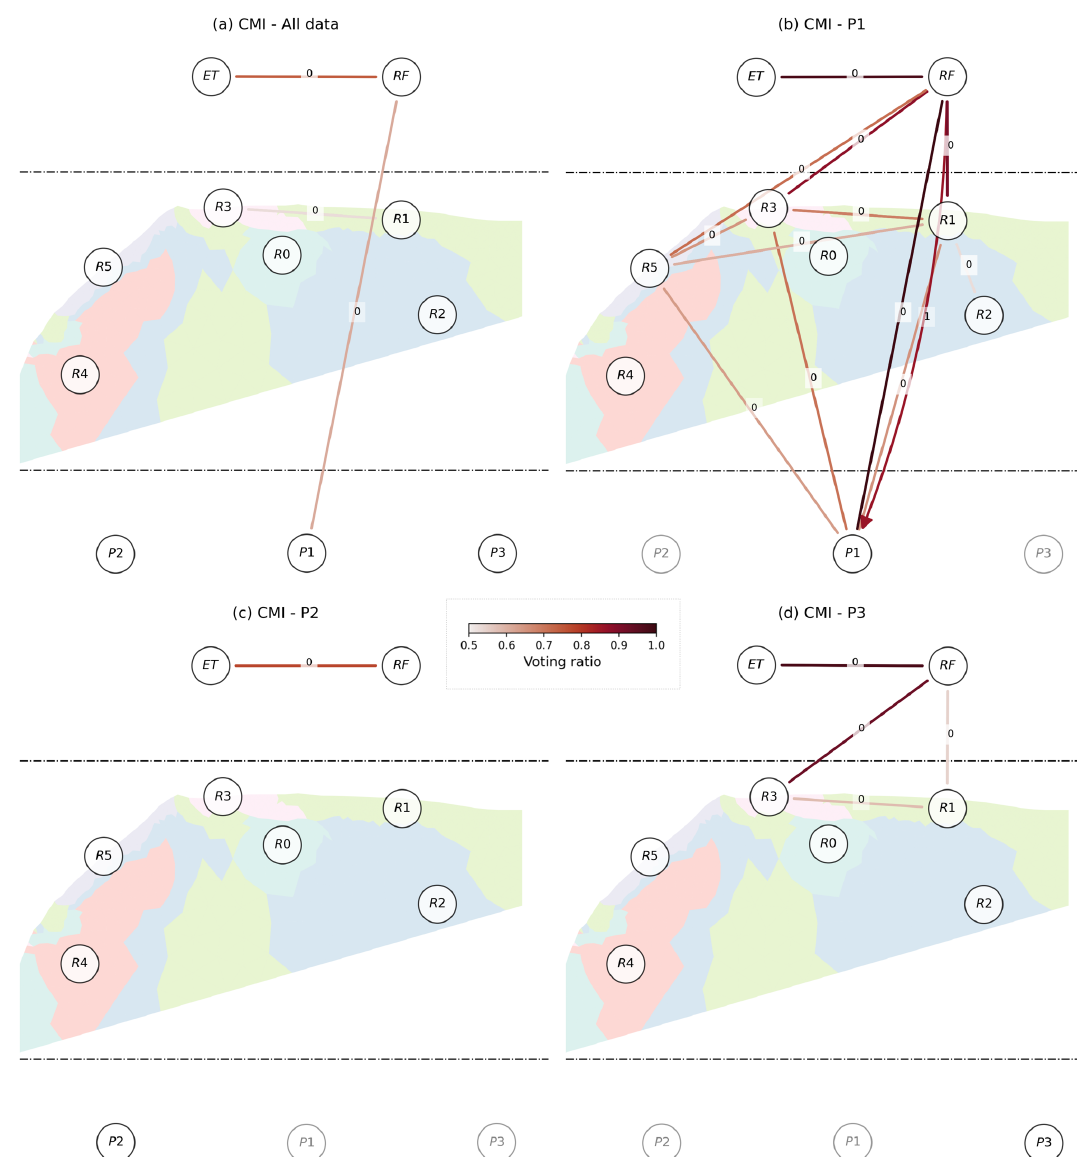
Figure 6. Consensual graph of CMI cross-dependencies obtained from the ensemble of simulations performed in the sensitivity analysis, considering (a) all data or one unique discharge series (b) P1, (c) P2, or (d) P3. An undirected line represents the contemporaneous de- pendencies. Delayed dependencies are shown using directed curved arrows. All corresponding delays d are displayed in the middle of its corresponding arrow. The links displayed are those reaching the majority (50%) for all causal graphs where the connections are established with a p value of significance at 0.05. The colors of the arrows map to the strength of the voting ratio. For each graph, the size of the overlapping time domain between the variables changes as follows: 48d (a) , 184d (b) , 62d (c) , and 218d (d)